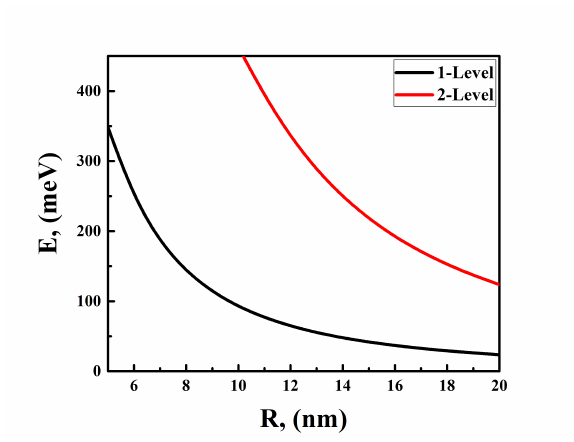
Fig. 4. Dependence of the electron energy on the radius of a cylindrical nanowire with a potential well of finite